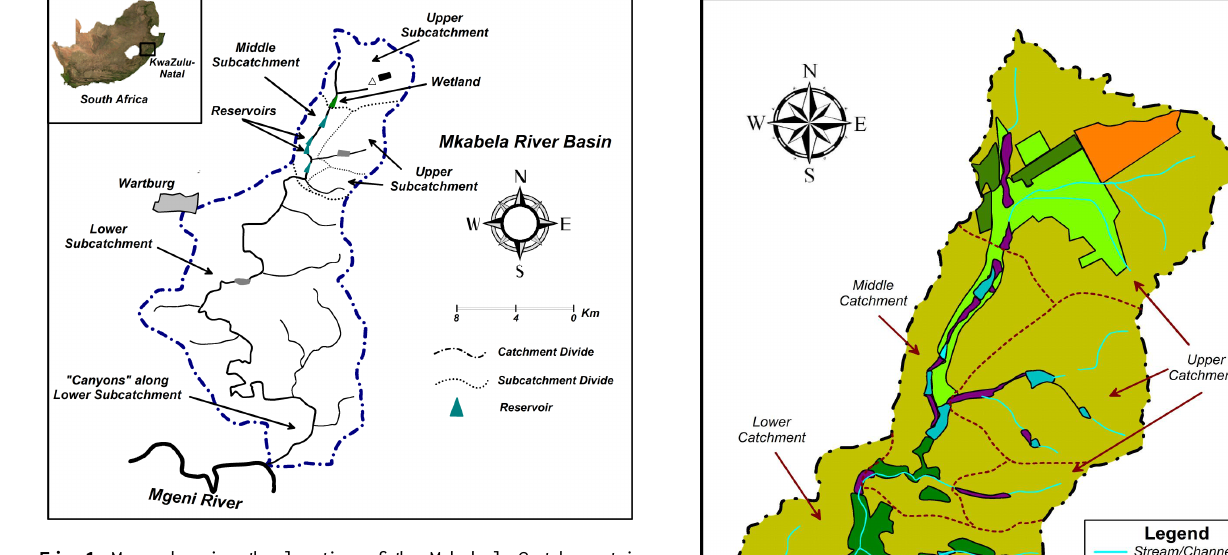
Fig. 1. Map showing the location of the Mkabela Catchment in South Africa and the position of the defined subcatchments within the basin.